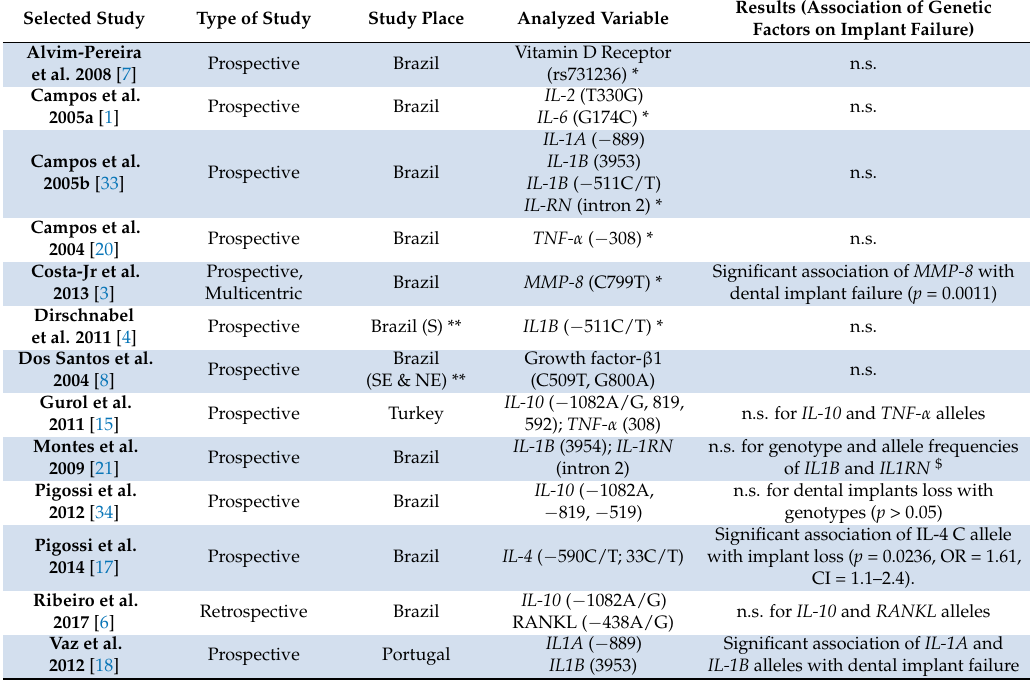
Table 1. A summarized data of the articles selected in this study and the association between genetic factors and dental implant